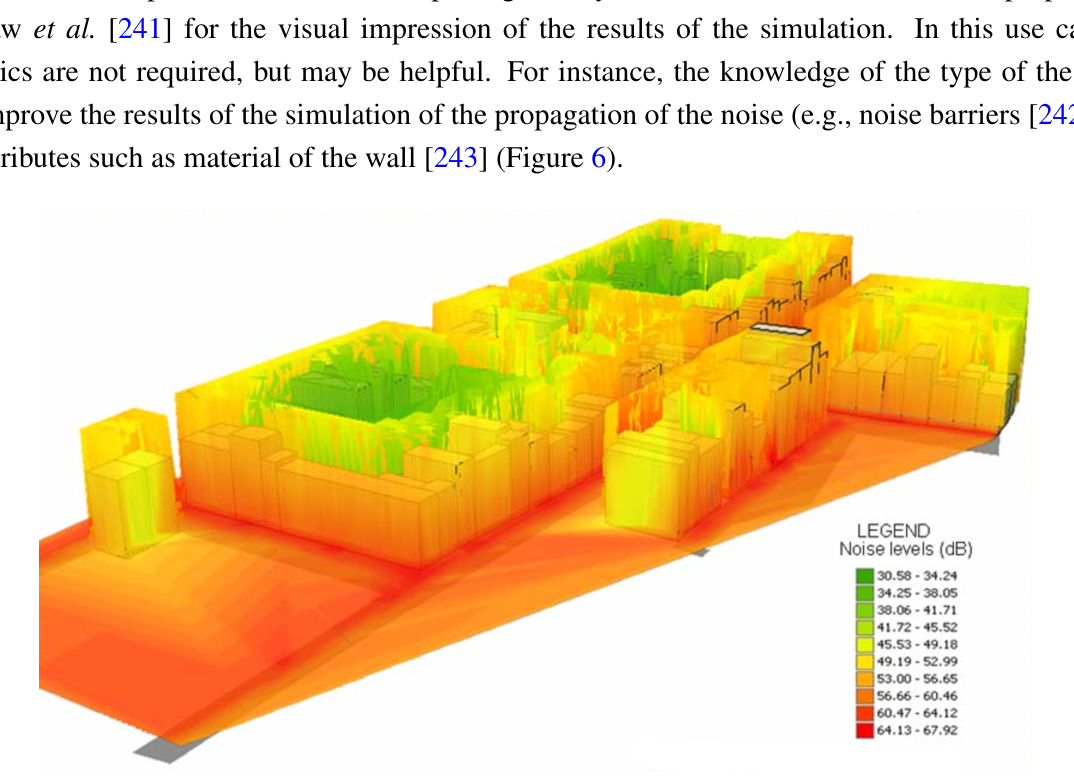
Figure 6. A 3D noise simulation derived with a 3D city model. (Image courtesy of Kurakula